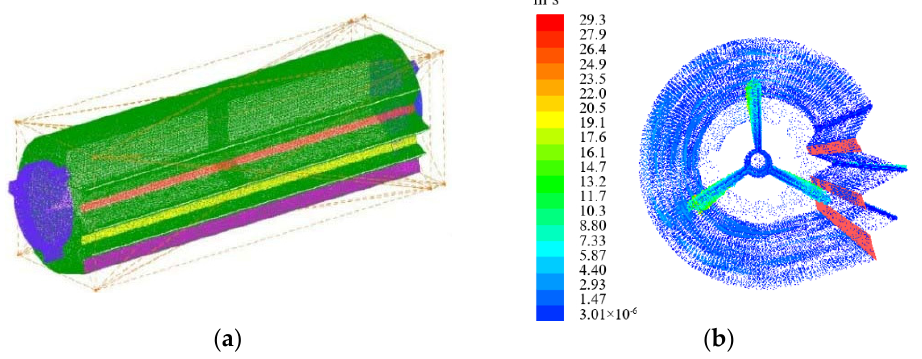
Figure 6. Mesh dividing and internal air velocity simulation of the three-channel centrifugal fan. ( a ) Mesh mode of centrifugal fan with three-channels. ( b ) Internal flow velocity vector diagram of the fan.